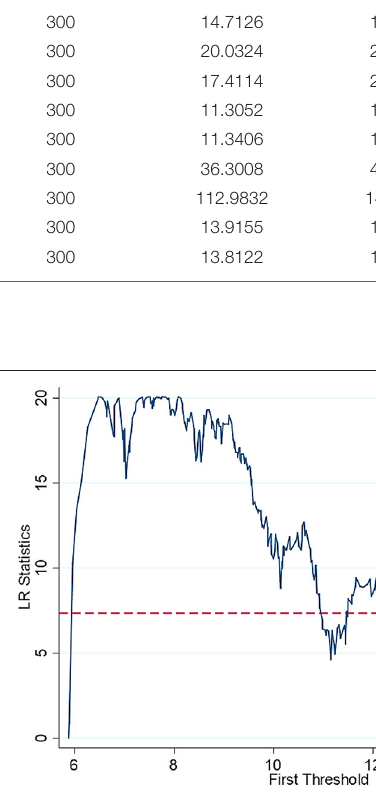
FIGURE 3 | Full sample threshold regression_single threshold